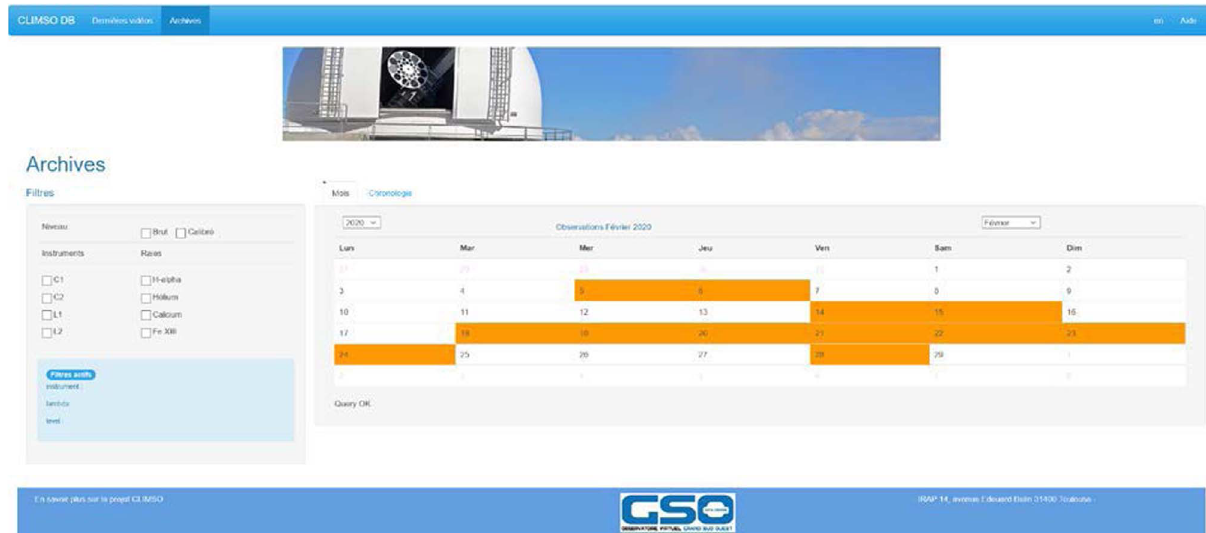
Fig. 11. Page of the full CLIMSO archive